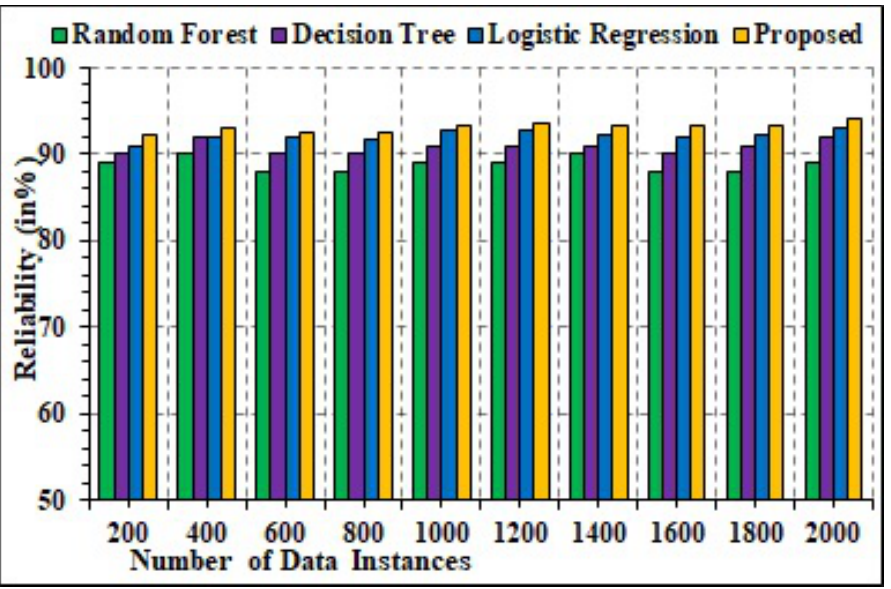
Figure 15. Reliability analysis.